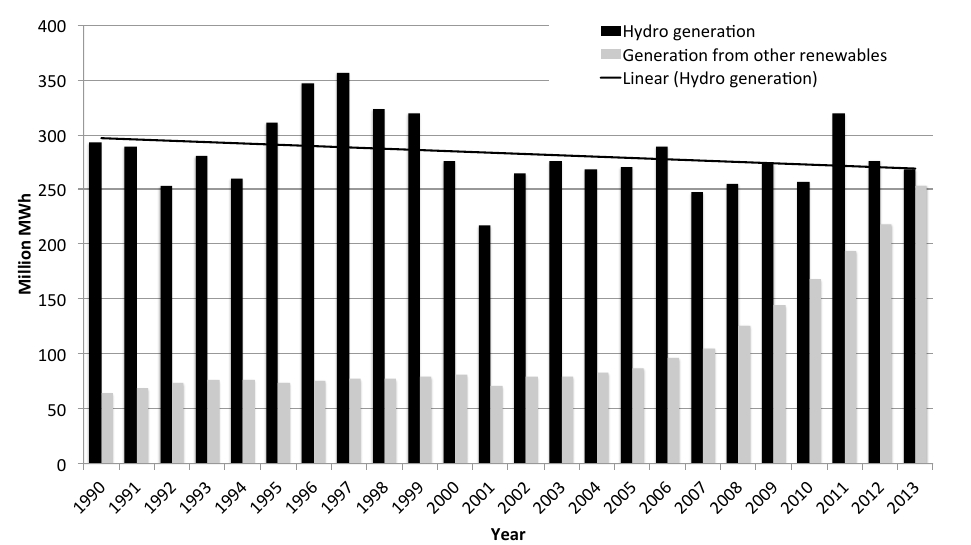
Figure 1. Trends in hydropower production and other renewables in the United States. Data are from http://www.eia.gov/electricity/annual/.